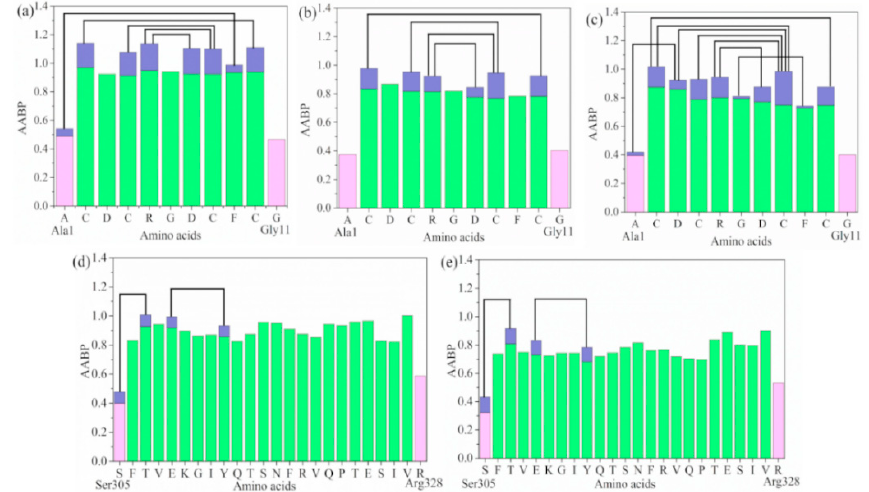
Figure 6. Distribution of AABP in ( a ) 1FUV; ( b ) 1FUV in 80 H 2 O molecules; ( c ) 1FUV in 100 H 2 O molecules; ( d ) SD1, and ( e ) SD1 in 300 H 2 O molecules. The color bar represents the following cases, light pink: sum AABP of AA with single nearest neighbor, green: sum AABP of AA with two nearest neighbors, light blue: AA with off-diagonal AABP. The black curve lines represent off-diagonal bonding between two AAs.